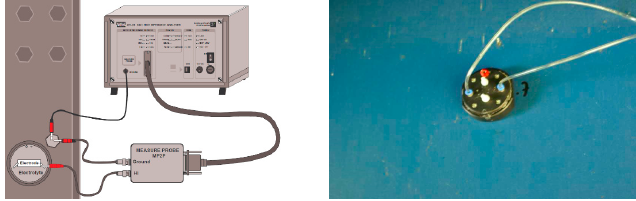
Figure 1. Set ‐ up of the EIS measurement device. Figure 1. Set-up of the EIS measurement Table 3. EIS measurement sites on bridge structures. Bridge/ EIS Measurement Sites Coating System According to Table 2